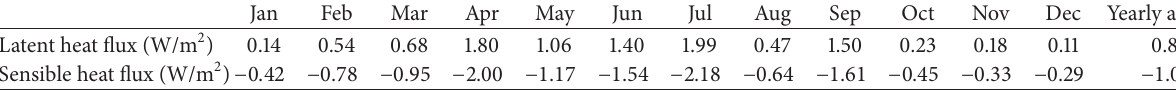
Table 3: Projected differences of monthly and annual heat fluxes between 2010 and 2050 in India.